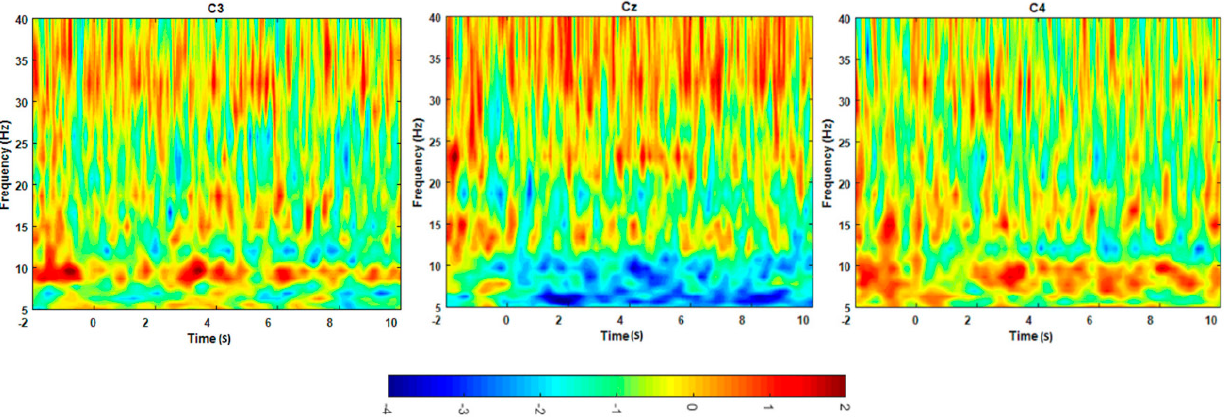
Figure 8. Time frequency map of the average across the participants during the ankle movements; the left map represents left motor cortex area C3, the middle image represents Cz area, whereas the right image represents right motor cortex area C4.